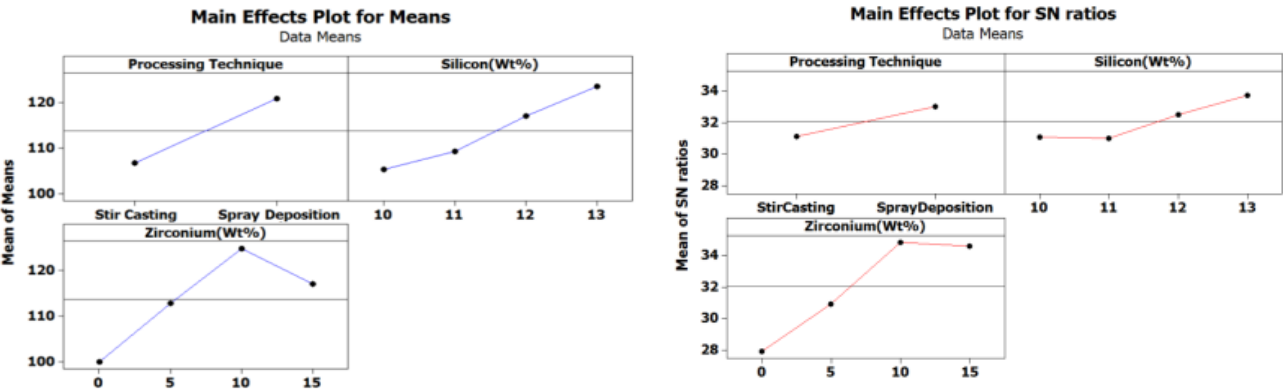
Figure 12. Main effects plot for micro hardness. Table 6. ANOVA for SN